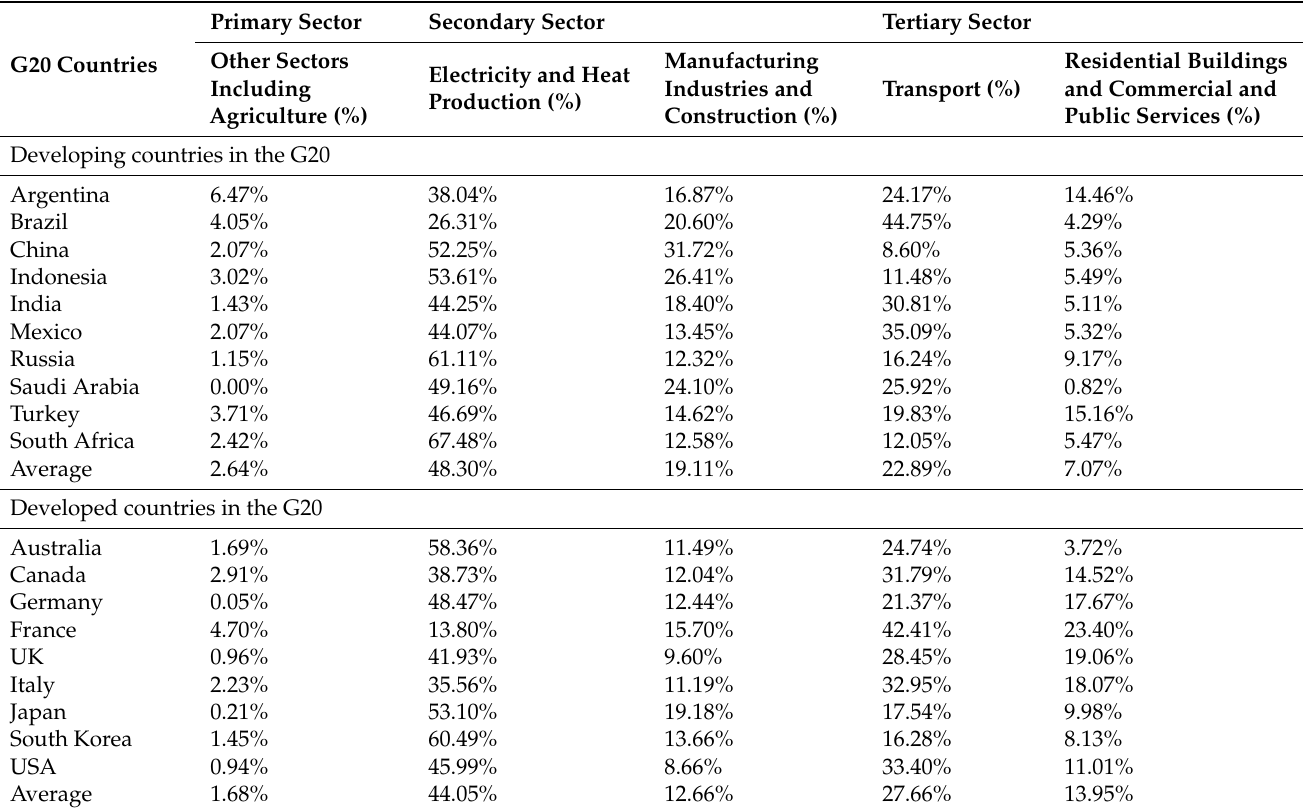
Table 1. CO 2 emissions by industry sector for G20 countries in